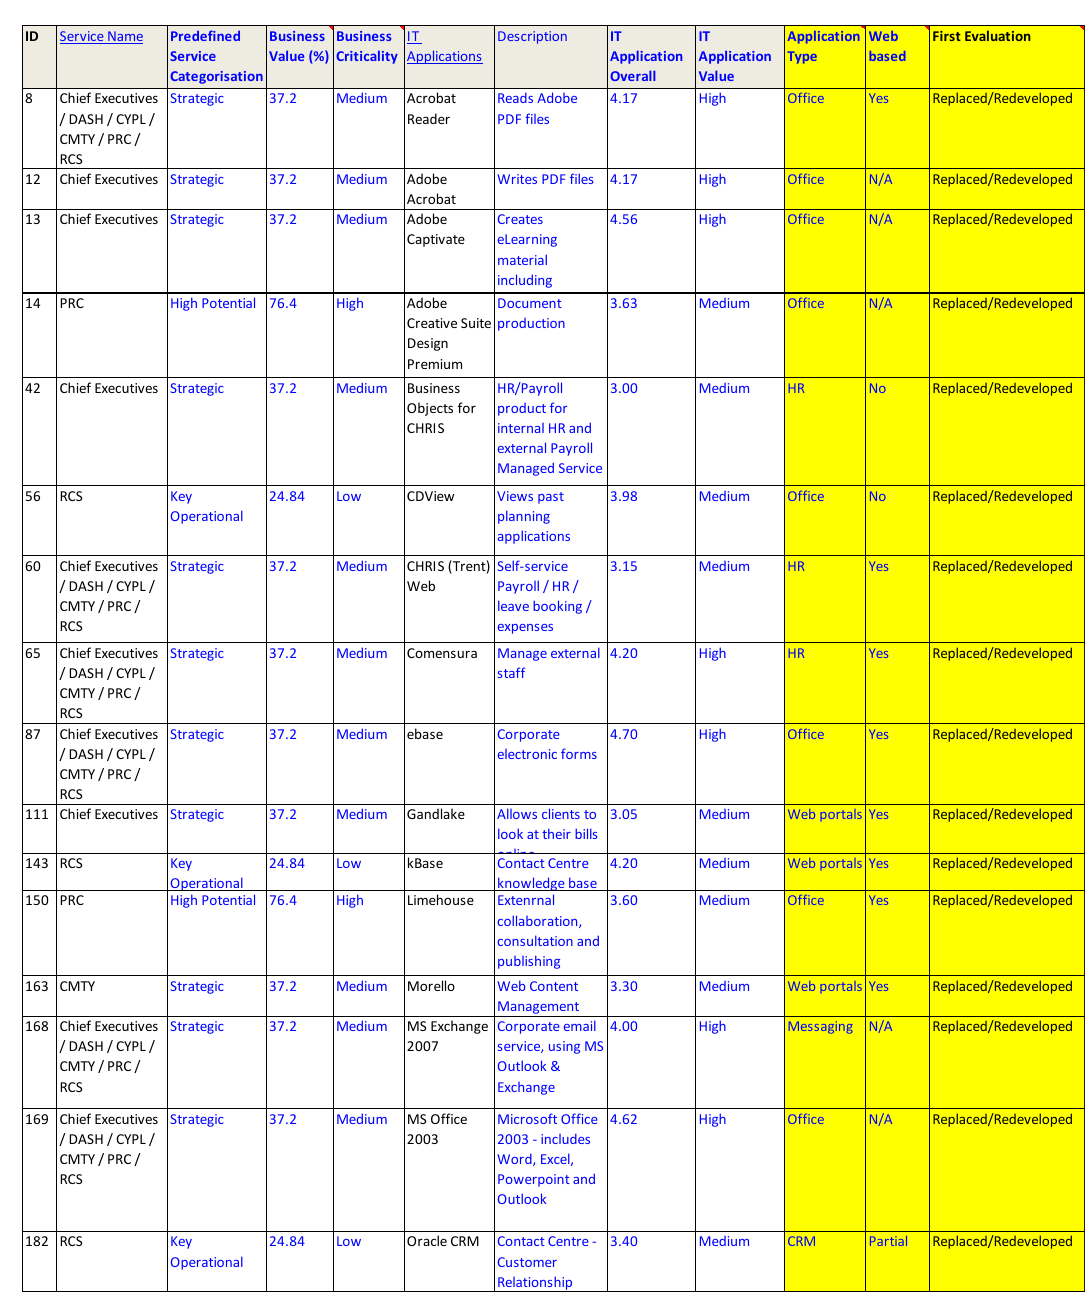
Figure 5. IS Services (Second Evaluation